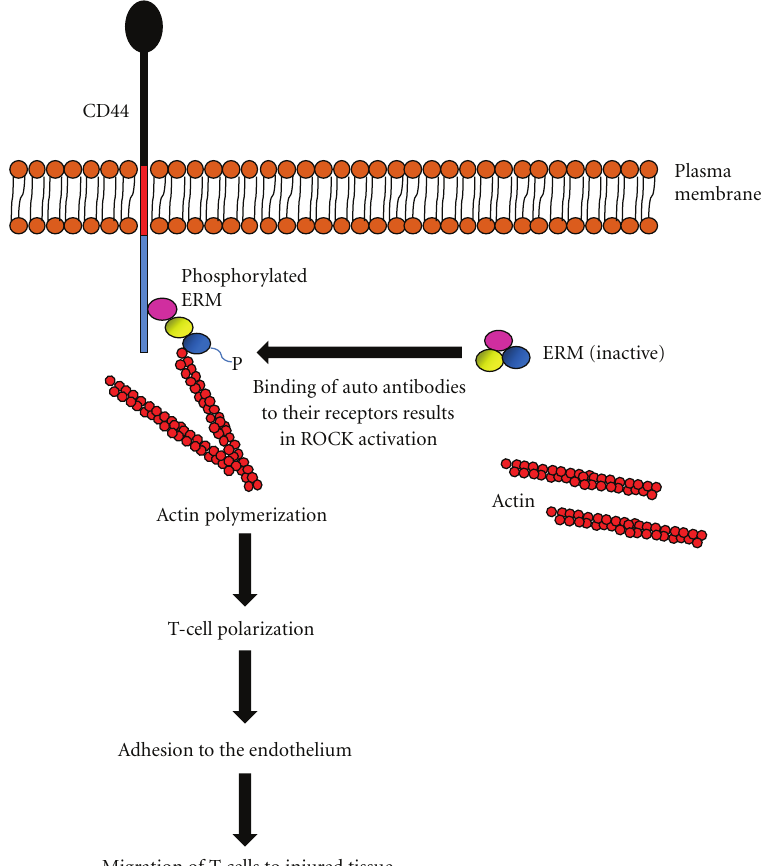
Figure 2: Schematic diagram showing the e ff ect of ERM activation on T-cell function in SLE patients. Autoantibodies such as anti-CD3/T- cell receptor (TCR) antibodies bind to CD3/TCR complex in circulating T cells and induce ROCK activation, which in turn mediates ERM phosphorylation. Once activated, ERM directly interacts with CD44 and F actin resulting in their colocalization at the polar caps of T cells, leading to actin polymerization, T-cell polarization, adhesion to the endothelium and subsequent chemotactic migration to sites of injury in the